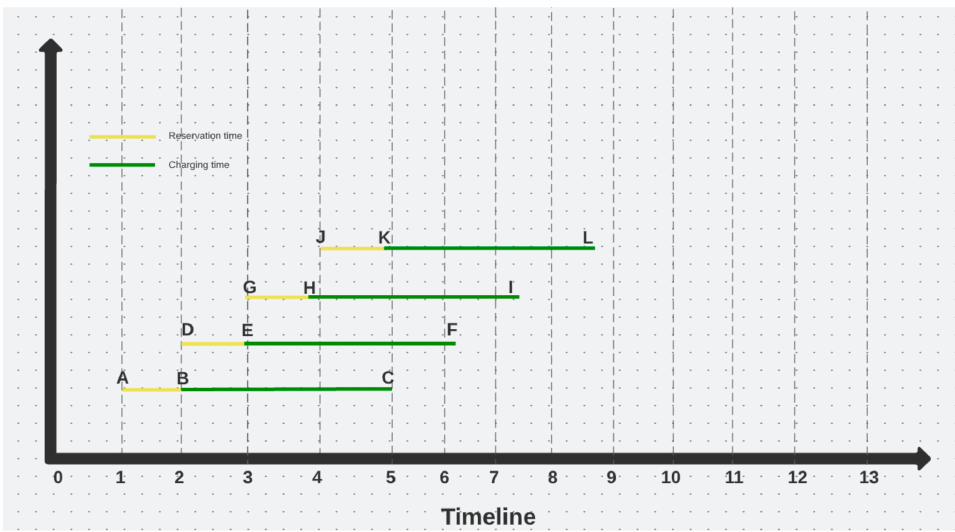
Figure 1. OCPP Reserve now.